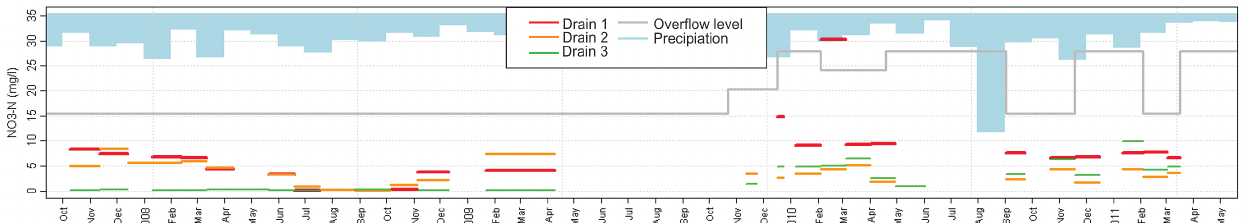
Figure 7. Results of the SorbiCell average NO 3 –N concentration measurements for the individual drains.